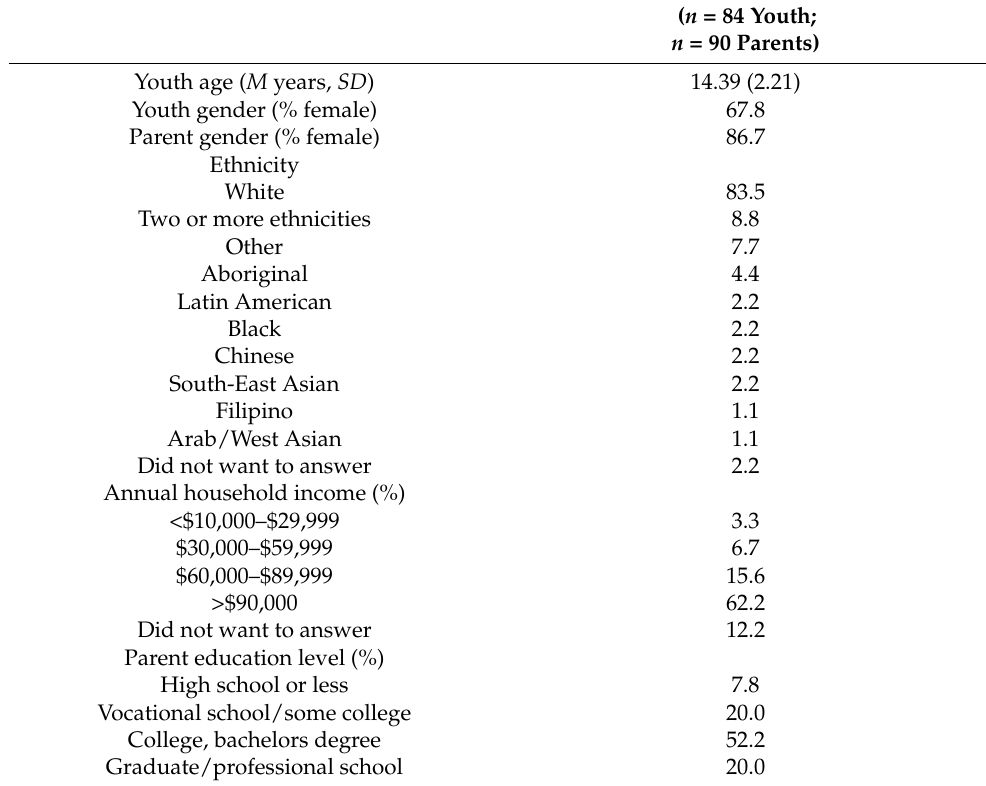
Table 1. Sociodemographic